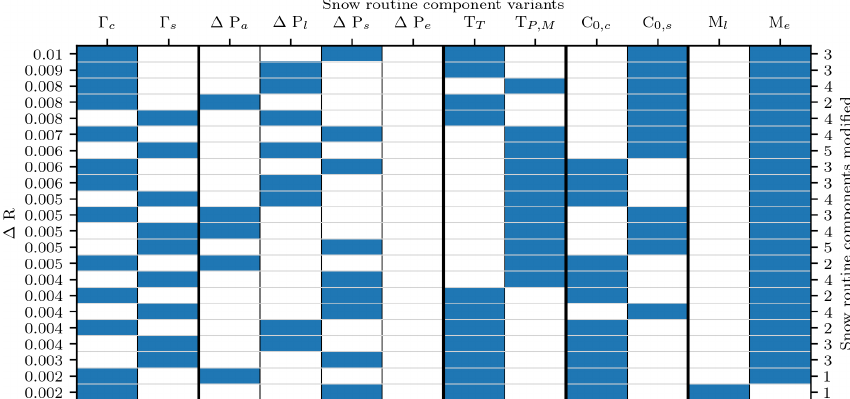
Figure 9. Ranked alternative structures of the snow routine of HBV that present positive relative model performance values with respect to HBV for model calibration and validation against snow water equivalent and stream runoff disaggregated by snow routine component variants. The alternatives for each of the considered model components are a linear and seasonally variable degree-day factor ( (cid:48) c and (cid:48) s respectively); an abrupt, linear, sinusoidal, and exponential precipitation phase partition ( (cid:49)P a , (cid:49)P l , (cid:49)P s , and (cid:49)P e respectively); a common and individualised threshold temperature for precipitation phase partition and snowmelt ( T T and T P , M respectively); a constant and seasonally variable degree-day factor ( C 0 , c and C 0 , s respectively); and a linear and exponential (with no refreezing) melt function ( M l and M e respectively). Every row contains one model structure with the selected variant for each of the components highlighted in blue. The median relative model performance for all modelling scenarios is given on the left y axis, while the number of model modifications in each alternative is provided on the right y